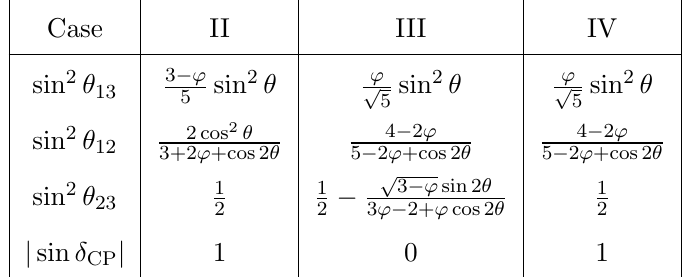
Z 2 ) and G (cid:23) = Z 2 CP derived (cid:2) (cid:2)